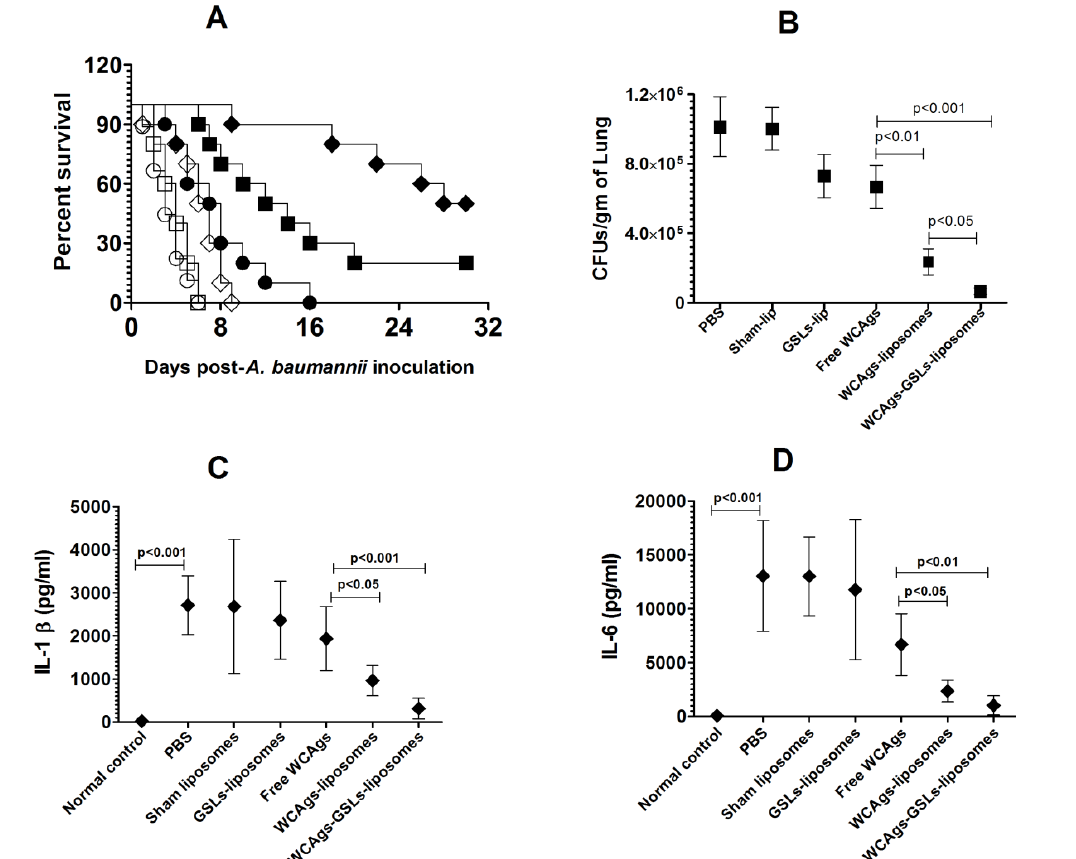
Figure 8. Immunization with WCAgs‑GSLs‑liposomes showed superior prophylactic potential against A. baumannii in immunocompromised mice. ( A ) Each control or immunized mouse was in- fected with 5 × 10 6 bacterial cells and monitored daily for 30 days. PBS ( # ), Sham‑lip ( 2 ), GSLs‑lip ( 3 ), free WCAgs ( • ), WCAgs‑liposomes ( ■ ), WCAgs‑GSLs‑liposomes ( ♦ ). WCAgs‑GSLs‑liposomes vs. WCAgs‑liposomes ( p = 0.0388), WCAgs‑GSLs‑liposomes vs. free WCAgs ( p < 0.001), WCAgs‑ liposomes vs. free WCAgs ( p = 0.0228). ( B ) The bacterial load was analyzed in the lung tissues, as described in the methodology section. ( C ) IL‑1 β and ( D ) IL‑6 levels in BAL fluid of the control and immunized mice. The values are expressed as the means ±